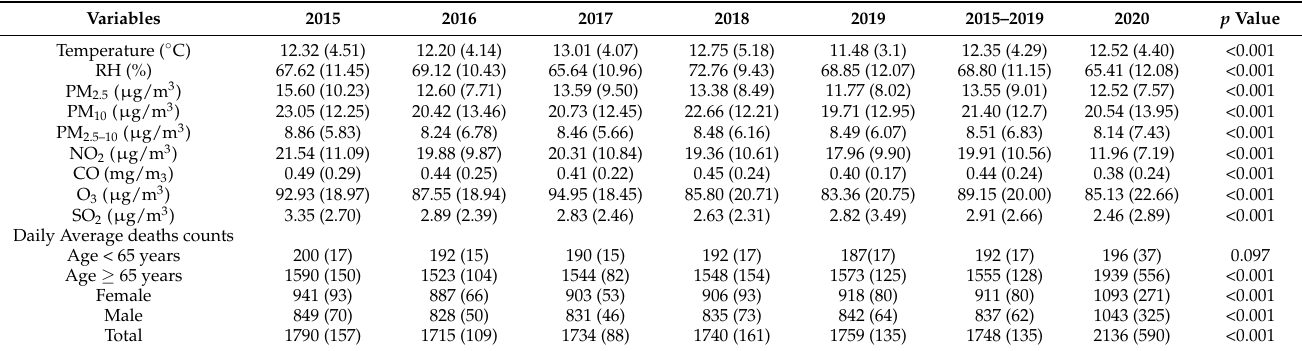
Table 1. Descriptive statistics for temperature, relative humidity, and death counts during the first three months of COVID-19